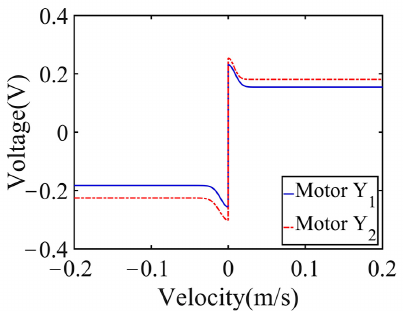
(39) Figure 7. Comparison of the dual-motor system FDC: ( a ) open-loop control; ( b ) closed-loop control; ( c ) closed-loop control with the designed FDC-UM. According to Equation (17), it is necessary to obtain the friction compensation voltage to accurately calculate the adaptive gain adjustment value. The Stribeck friction model is a commonly used friction model that can more comprehensively reflect the change in the friction of the guide when the PMLSM moves continuously [29]. Based on the Stribeck friction model, the functions of the friction compensation voltage are shown in Equations (40) and (41), and the curves are shown in Figure 8. From Figure 8, we can see the high nonlinearity and complexity of friction, and there is a sudden change in friction during the low-speed period, which seriously deteriorates the accuracy of the motor system. However, when the speed reaches a certain value, the friction remains within a certain range. At this time, the friction changes very little; therefore, the friction compensation voltage used in the calculation of Equation (17) can be clearly obtained. (